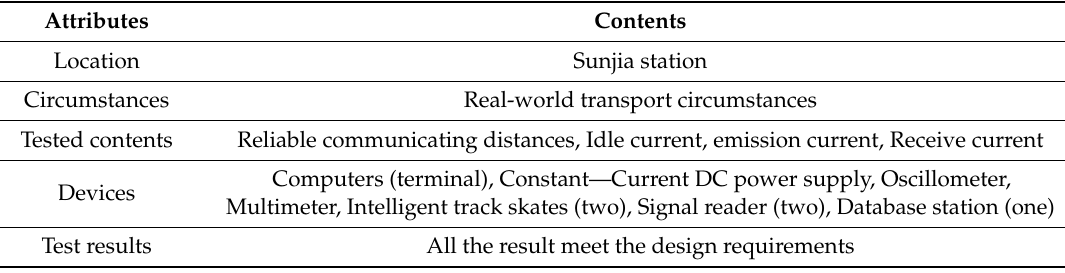
Table 1. Conditions and contents tested.